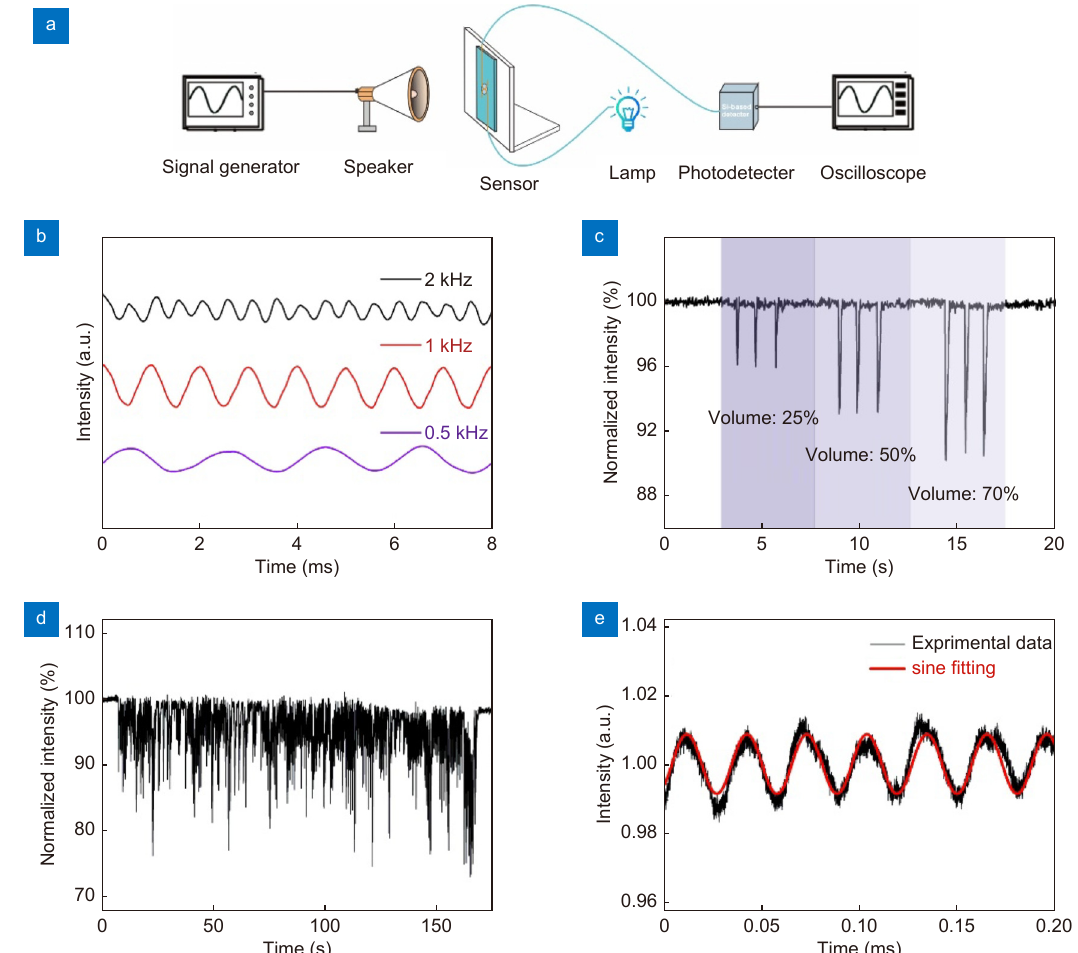
Fig. 4 | Characterization of the sensor for sound detection. ( a ) Schematic diagram of the experimental setup for sound detection. ( b ) The device response to sinusoidal sound waves at 0.5 kHz, 1 kHz, 2 kHz, respectively. ( c ) The device response to a metronome at three different volumes (25, 50, and 70%). ( d ) The device response to a piece of music. ( e ) The sensor’s response to ultrasonic vibrations with a frequency of 30